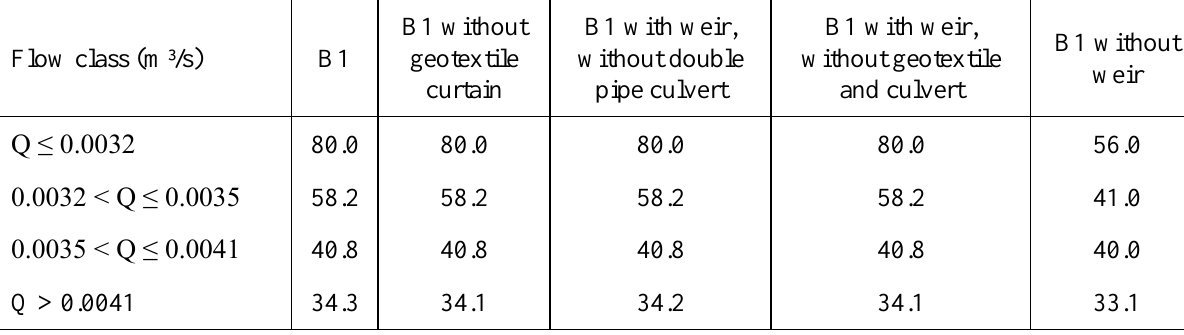
Table 6. TE of different configurations of Basin B1.